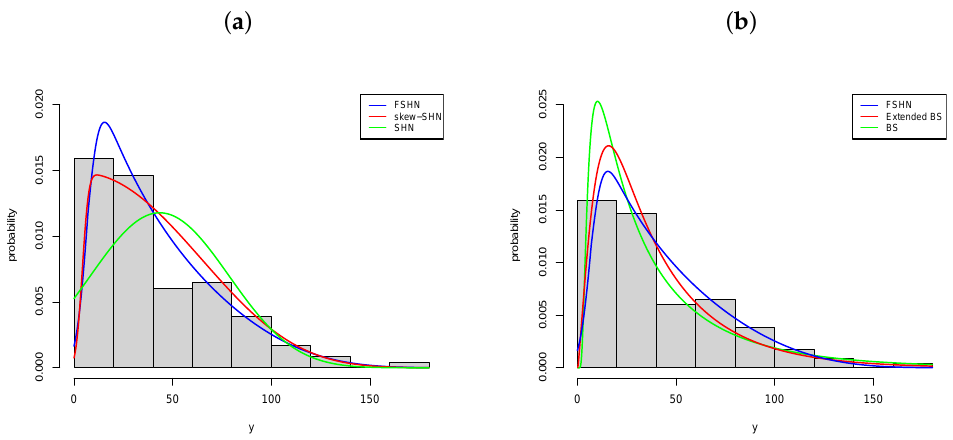
Figure 4. Estimated pdfs: ( a ) FSHN (blue), skew-SHN (red) and SHN (green); and ( b ) FSHN (blue), extended BS (red) and BS (green).